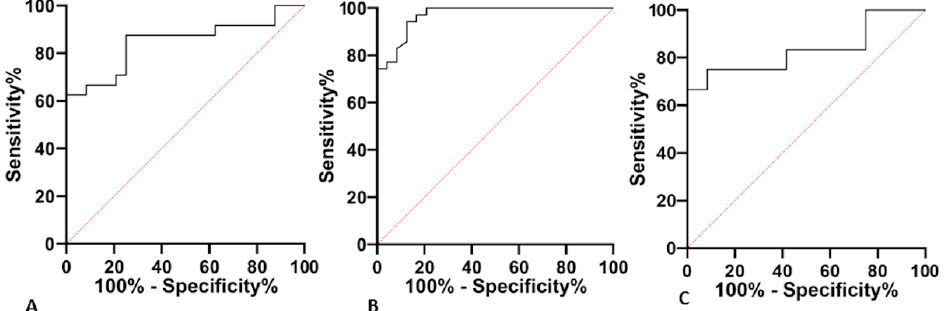
Figure 2. The receiver operating characteristic curve (ROC) results of serum miR-133a-3p together with miR-106b-5p. ( A ) AUC = 0.84, p < 0.001 svPPA vs. controls; ( B ) AUC = 0,95, p < 0.001 svPPA vs. lvPPA + nfvPPA0; ( C ) AUC = 0,83, p = 0.0056 AD-negative svPPA vs. AD-positive lvPPA + AD-positive nfvPPA.